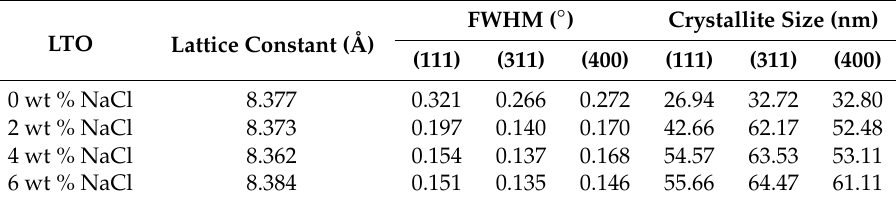
Table 1. The structural parameters of LTO